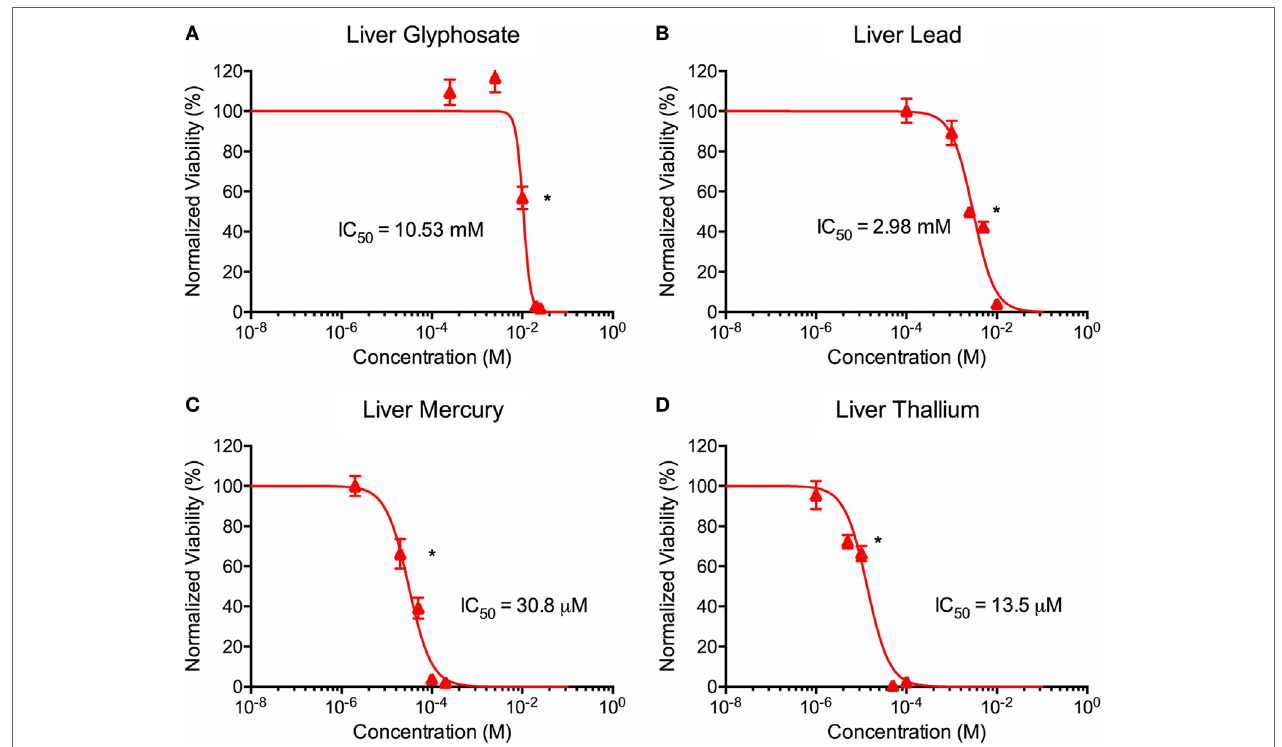
FigUre 3 | Environmental toxin effects on liver organoid ATP activity. ATP survival curves for liver organoids exposed to glyphosate (a) , lead (B) , mercury (c) , and thallium (D) over the course of two days. Adjusted ATP activity is a comparison of the ATP value of organoids exposed to toxins over the control liver organoids. Statistical significance: * p < 0.01 with bracket encompassing all doses with this value. IC50 value was determined through calculation of line crossing the IC50